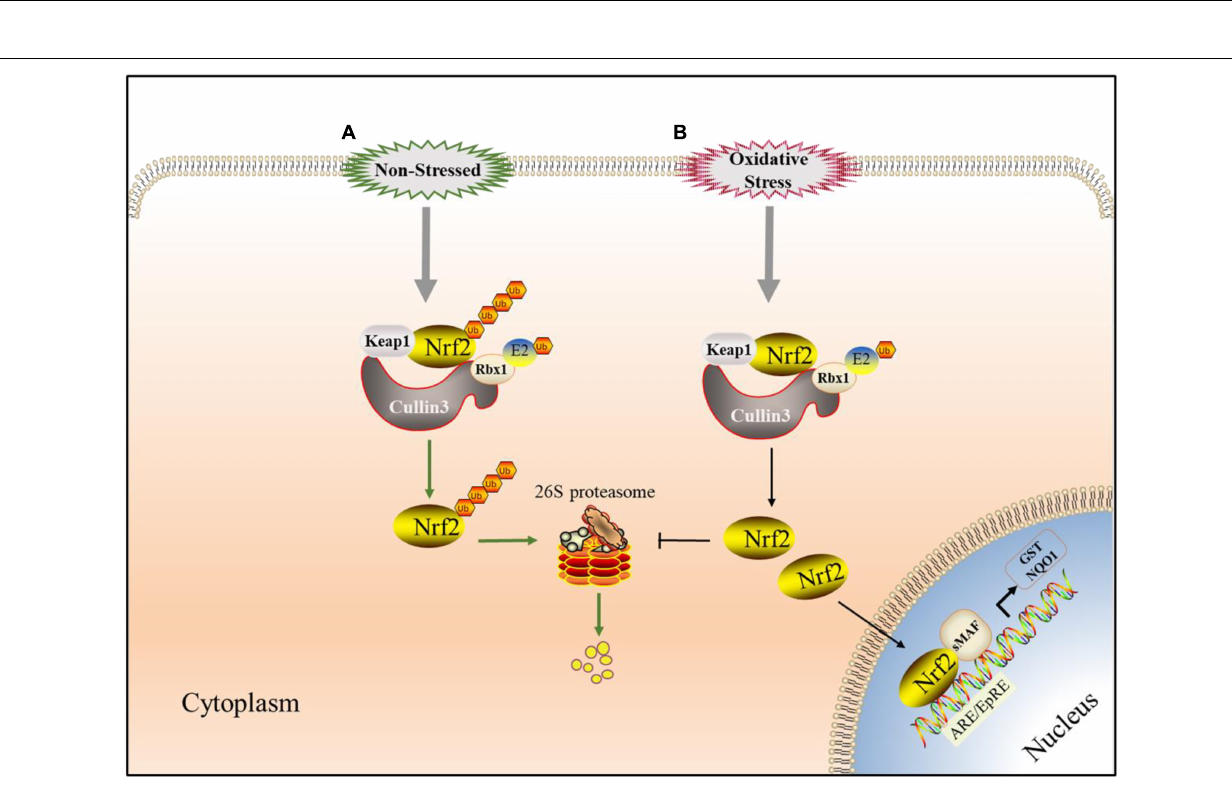
FIGURE 4 | Keap1-Nrf2 signaling pathway involved in UPS. (A) Under non-stressed conditions, Nrf2 binds to Keap1 complex which has E3 ligase activity in the cytoplasm. When Nrf2 is ubiquitinated, it is targeted to the 26S proteasome for proteolysis which keep it low in cytoplasm. (B) Under oxidative stress conditions, Critical cysteine residues in Keap1 is covalently-modified by electrophilic species or reactive oxygen species (ROS) and Nrf2 avoides Keap1-mediated ubiquitination modification. Then Nrf2 translocated to the nucleus, starts ARE/EpRE transcription through heterodimerization with SMAF protein, and induced the expression of a series of cytoprotective